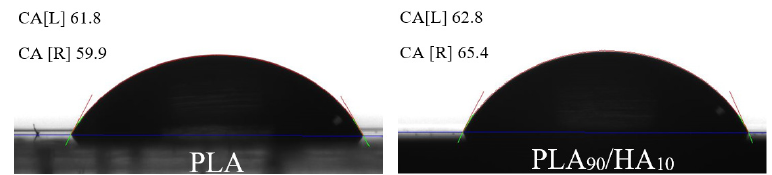
Figure 6 . Water contact angle of PLA ( left ) and PLA 90 /HA 10 ( right ). Figure 6. Water contact angle of PLA ( left ) and PLA 90 /HA 10 ( right